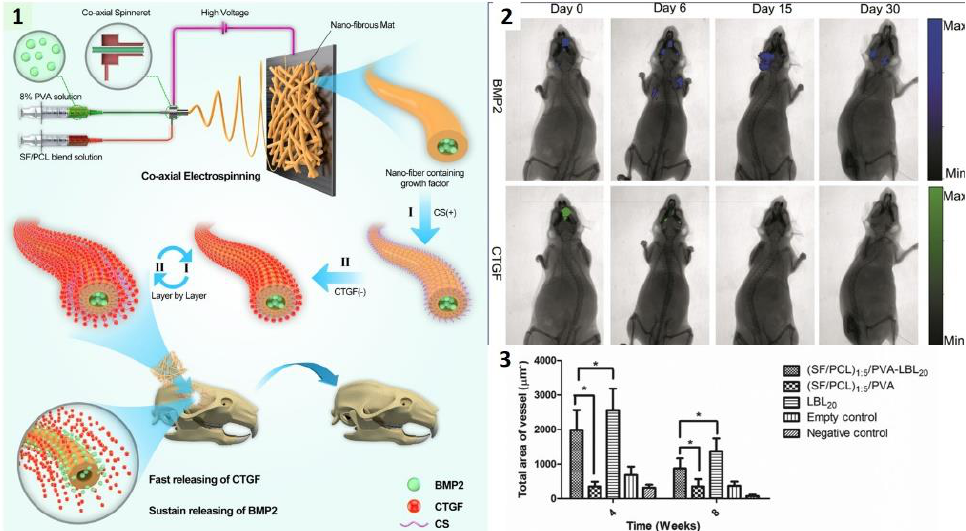
Figure 5. Multilayer NF loaded with growth factors for bone healing ((SF/PCL) 1:5 /PVA-LBL20). ( 1 ) Core-shell NFs with MBP2-loaded core is functionalized by successive layers of chitosan and the second growth factor, CTGF. ( 2 ) Time-controlled release of growth factors after intracranial implantation. ( 3 ) Temporal development of microvasculature formation. * p < 0.5 Adapted with permission from [144]. Copyright 2019 American Chemical Society.